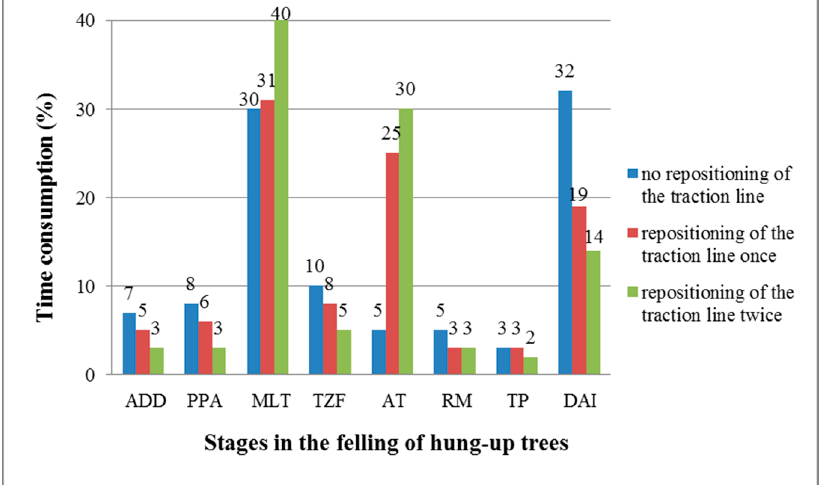
Figure 6. Working time consumption in the felling of hung up trees according to stages: ADD–choice of the felling direction, of the work technique and of the tree rotation direction; PPA–preparation of anchorage points and creation of escape routes; MLT–assembling the TL; TZF–cutting the hinge wood; AT–operating the hand winch; RM–workers’ retreat, tree falling and workers’ come back; TP–cutting the pivot; DAI–dismantling and packing the TL.